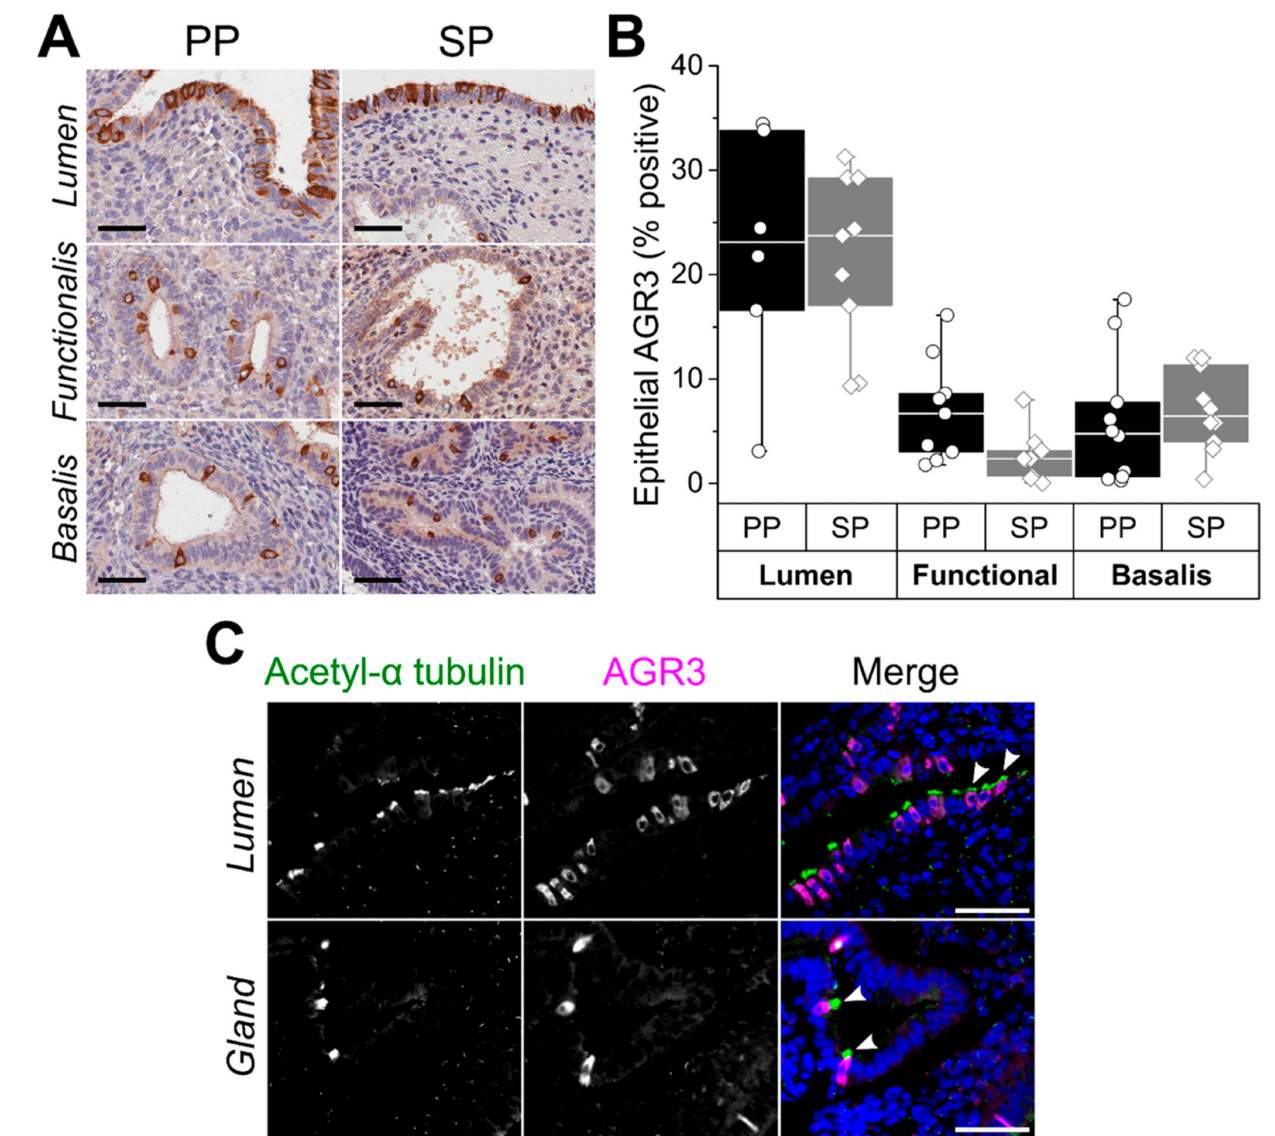
Figure 1. Anterior gradient protein 3 (AGR3) expression in the healthy human endometrium. ( A ) Representative micro- graphs demonstrate AGR3 immunostaining in proliferative phase (PP) and secretory phase (SP) endometrium. ( B ) Epithelial AGR3 immunostaining scores across subanatomical regions of the cycling endometrium. ( C ) Representative immunofluores- cence micrographs show co-staining of acetylated- α tubulin (green) and AGR3 (magenta) in ciliated luminal and glandular endometrial epithelial cells. Tissue sections were counterstained with DAPI (blue). Ciliated cells expressing AGR3 are highlighted with white arrowheads. Scale bars 50 µ m